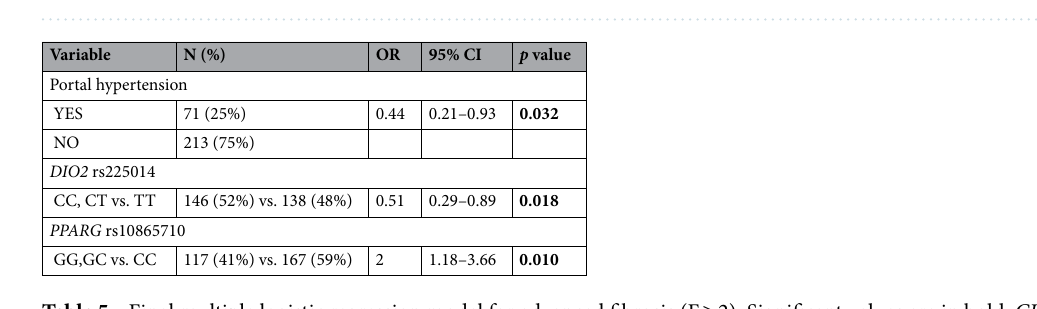
Table 5. Final multiple logistic regression model for advanced fibrosis (F ≥ 2). Significant values are in bold. CI confidence interval, OR odds ratio; p value .